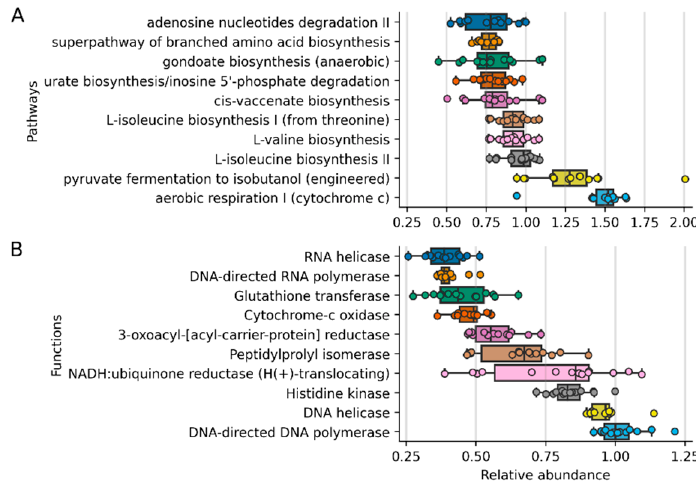
Figure 3. Most relatively abundant inferred pathways and functions employing PICRUSt2 ( A ). The 10 most abundant inferred pathways surpassed the 0.5% threshold. ( B ). The 10 most abundant inferred functions abundances surpassed the 0.35% threshold.